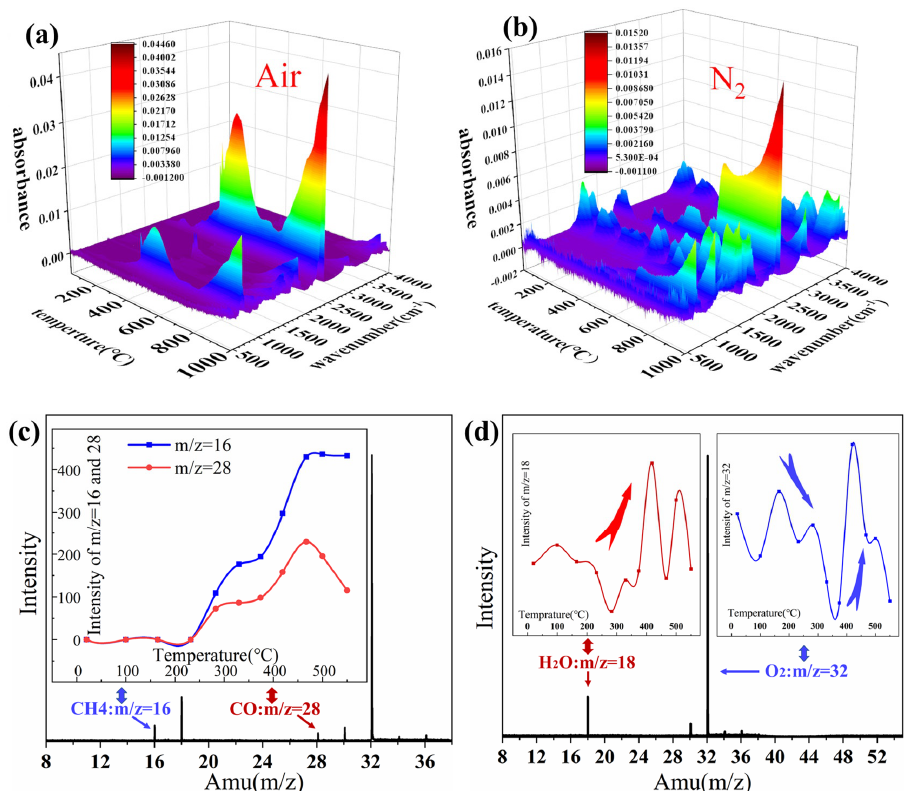
Figure 6. TG-IR spectra of the untreated silica aerogel under ( a ) air and ( b ) N 2 . ( c ) SVUV-PIMS of background and signal intensity trends of m/z = 18 and 32. ( d ) SVUV-PIMS at 450 °C and signal intensity trends of m/z = 16 and 28.